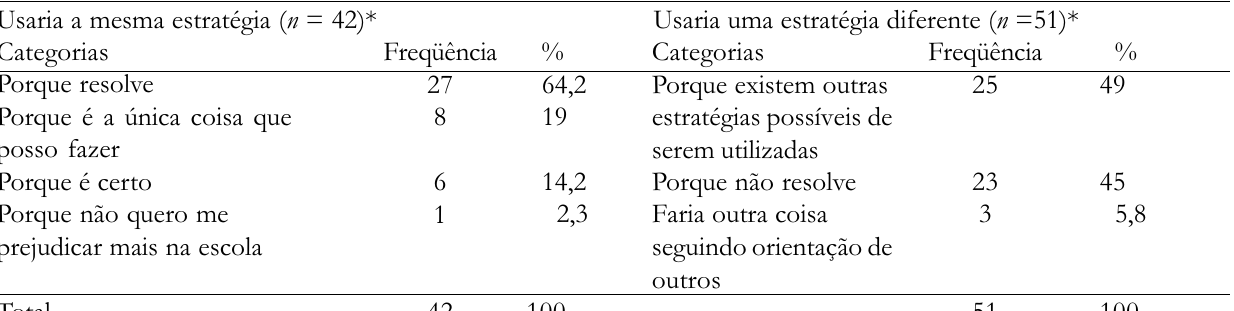
Freq(cid:252)Œncias e Percentagens das Categorias Referentes (cid:224)s Justificativas da Auto-Avalia(cid:231)ªo das Crian(cid:231)as sobre suas EstratØgias de Coping Relacionadas aos Problemas com os Colegas (respostas